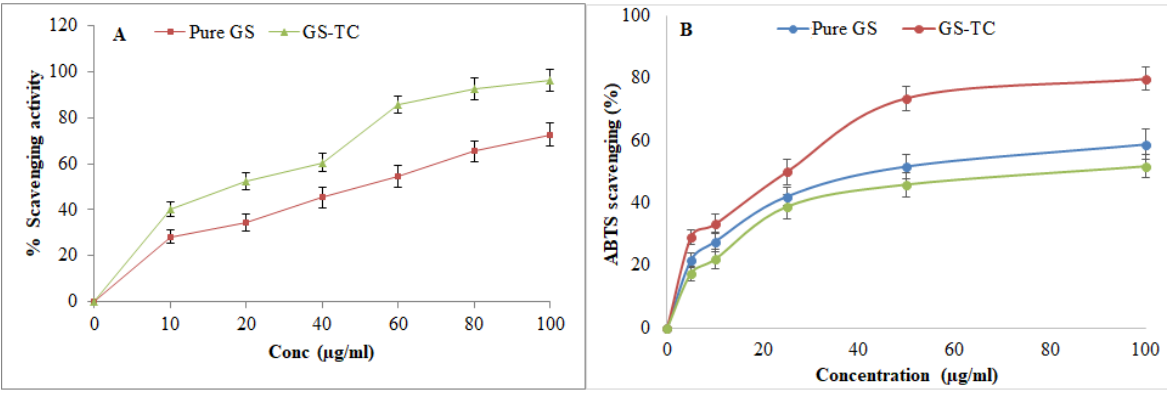
Figure 9. SEM image of ( A ). pure Genistein (GS) and ( B ). Genistein ternary complex (GS TC).